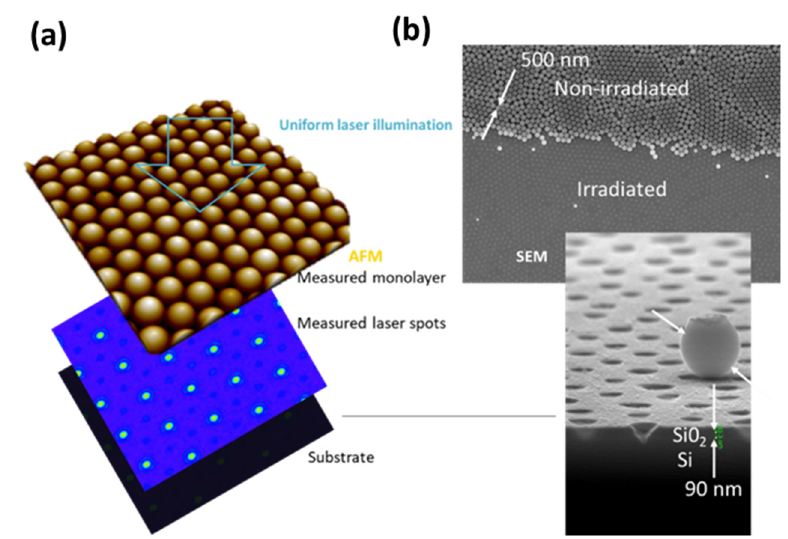
Figure 6. Porous membrane prepared by microsphere-assisted laser ablation. ( a ) Sketch illustrating the methodology in which a monolayer of dielectric microsphere is prepared (atomic force microscopy (AFM) image) to produce an array of near-field small spots, as shown by optical microscopy with top-illumination at a 400 nm wavelength in the plane supporting the monolayer. ( b ) Oxidized silicon surfaces supporting a monolayer of silica spheres (500 nm diameter) and partially irradiated with a nanosecond ultraviolet (UV) laser for periodic ablation. The SEM tilted view shows that the 90 nm oxide layer is perforated, leading to the formation of a porous membrane.